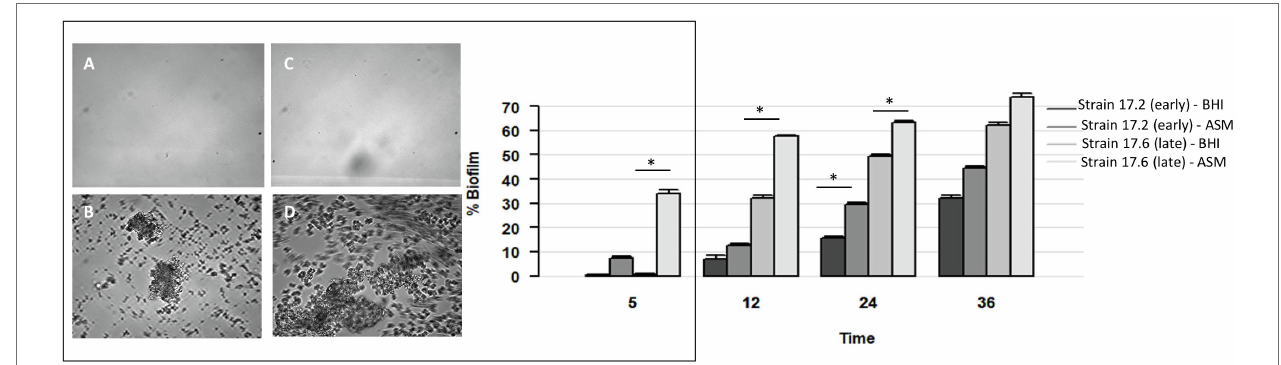
FIGURE 4 | Dynamics of biofilm formation in BHI medium and ASM in the absence of antibiotics for two strains isolated 3 years apart in Patient 17 (strain 17.2: “early” strain and 17.6: “late” strain). Left: Biofilm formation after 5 h of incubation: (A,B) early strain 17.2 in BHI medium (A) and ASM (B) ; (C,D) late strain 17.6 in BHI medium (C) and ASM (D) . Right. Percentage of biofilm formed over time (in hours). p -values are indicated for comparisons of biofilm formed by a strain depending on the culture medium at each time of the assay. * Value of p < 0.05 using t test.